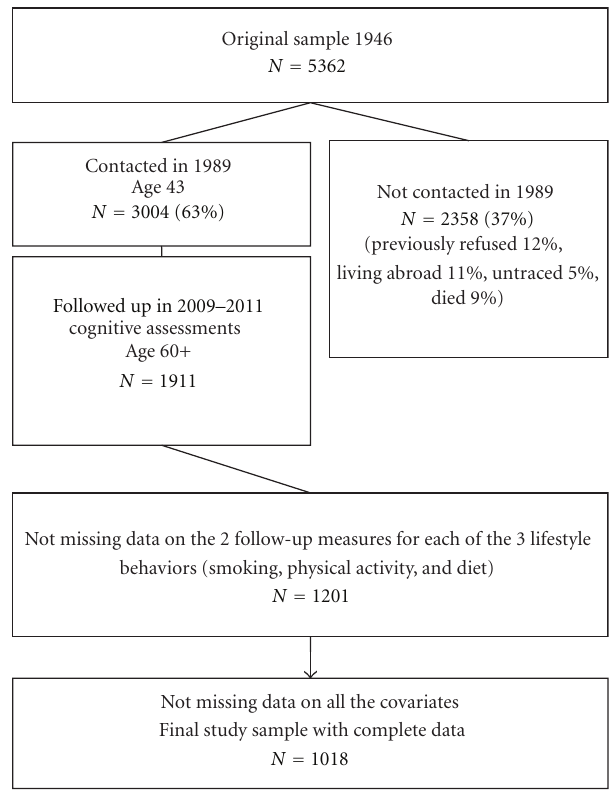
Figure 1: Flow chart of lifestyle behaviors, cognitive functioning and covariates data follow up (considered since baseline cognition- at age 43) in the Medical Research Council National Survey of Health and